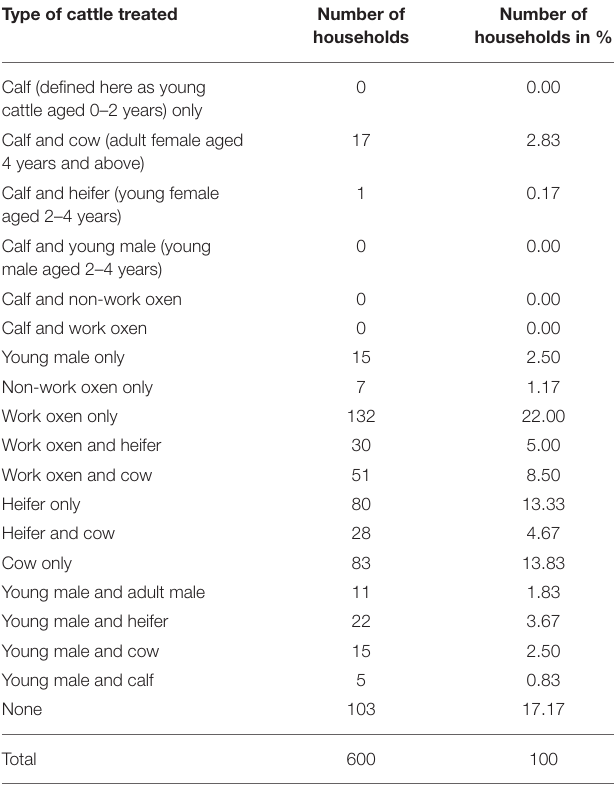
TABLE 1 | Types of cattle most often treated for ticks and tsetse flies in each household. Type of cattle treated Number of